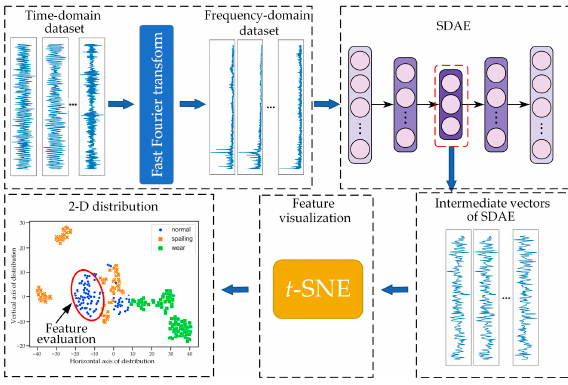
Figure 1. Flowchart of the VSDAE model.